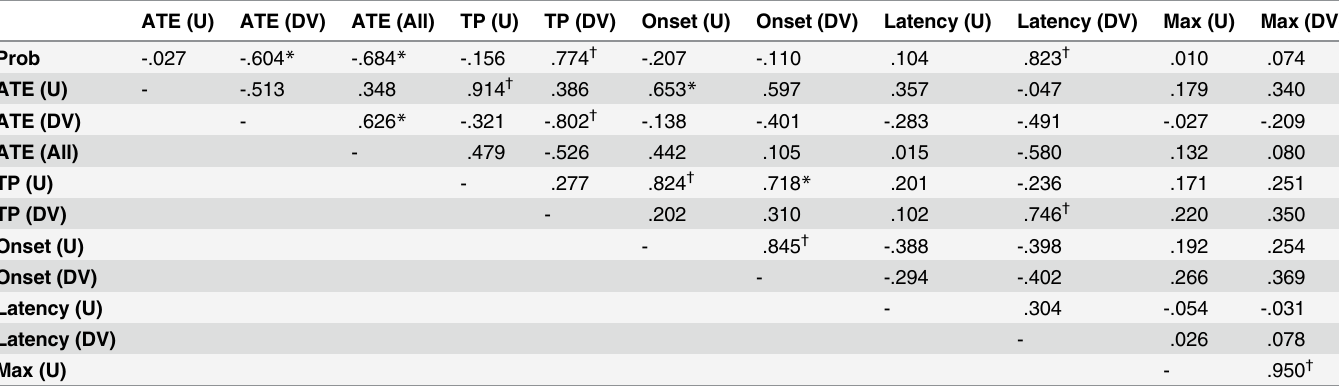
Table 3. Inter-subject correlations (r) between parameters (n = 11).